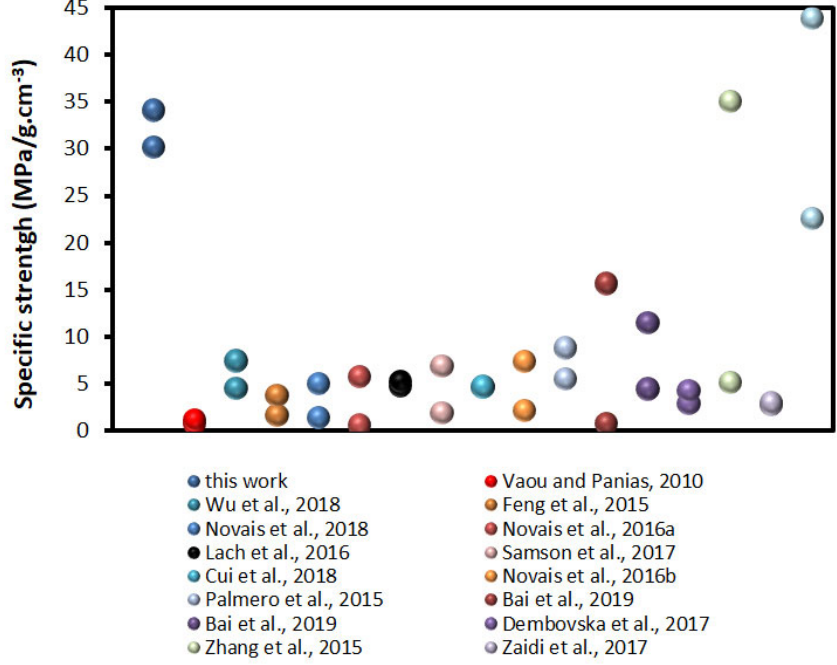
Figure 5. Review and literature comparison considering speci fi c strength in lightweight geopolymer